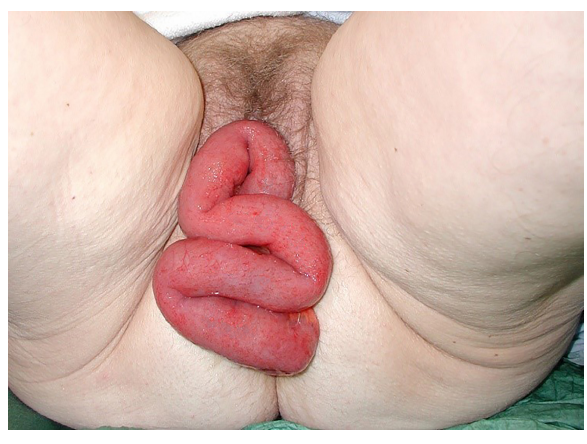
Figure 1 - Rupture of vaginal vault prolapse.